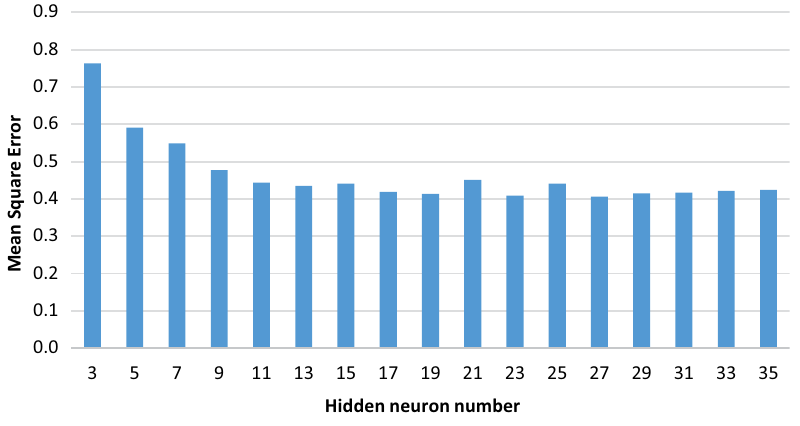
Figure 10. Influence of hidden neuron number on F 3 net